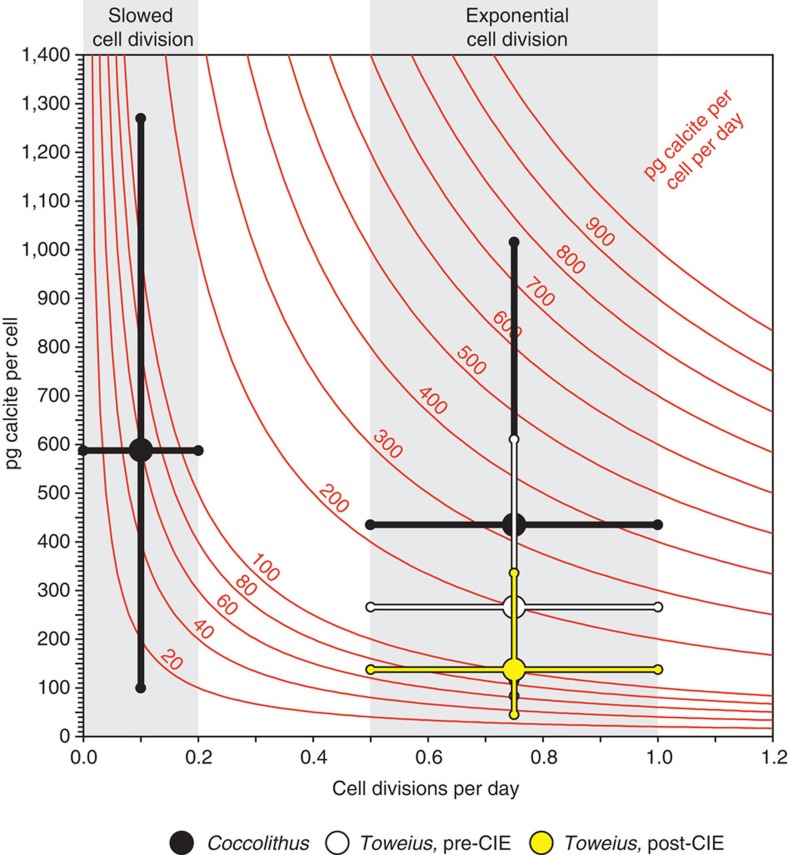
Estimating calcification rate for fossil coccolithophore species.Calcification rates (curved red lines) are derived by multiplying the amount of calcite produced per cell by the number of cell divisions per day. Mean (large circles) and the 5th and 95th percentiles (vertical lines) of coccosphere calcite quotas are shown (Toweius in white and yellow for pre- and post-CIE onset populations, respectively; Coccolithus in black). Populations exhibiting exponential phase coccosphere geometry (normal rates of cell division) are plotted between 0.5 and 1.0 divisions per day and likely vary within this range. Coccolithus populations that are exhibiting early stationary phase coccosphere geometry (slowed division; characterized by a high proportion of CN≥16) across the onset and peak of the PETM are plotted between 0 and 0.2 divisions per day. Small circles indicate intersections between calcification rates and either the measured percentile range of coccosphere calcite quotas (on vertical lines) or the inferred range of divisions per day (on horizontal lines).